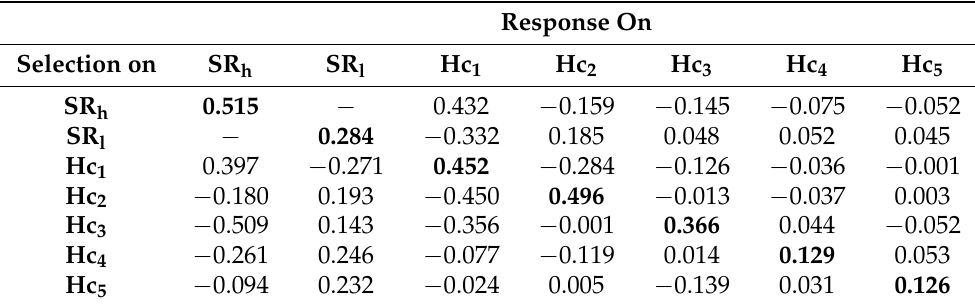
Table 8. True selection response 1 from the same trait (on diagonal and bold) and from different traits 2 (off diagonal) in ungenotyped individuals.